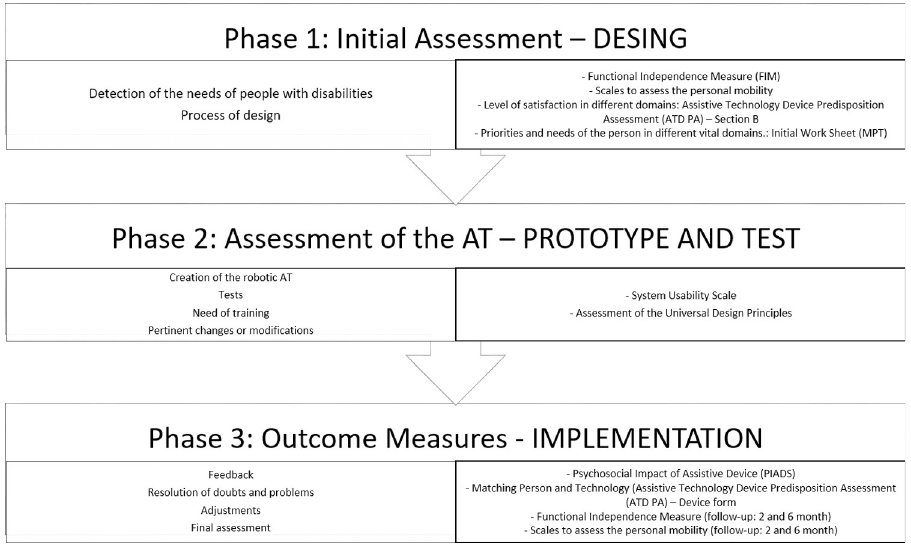
Fig 3. Structure of the assessment